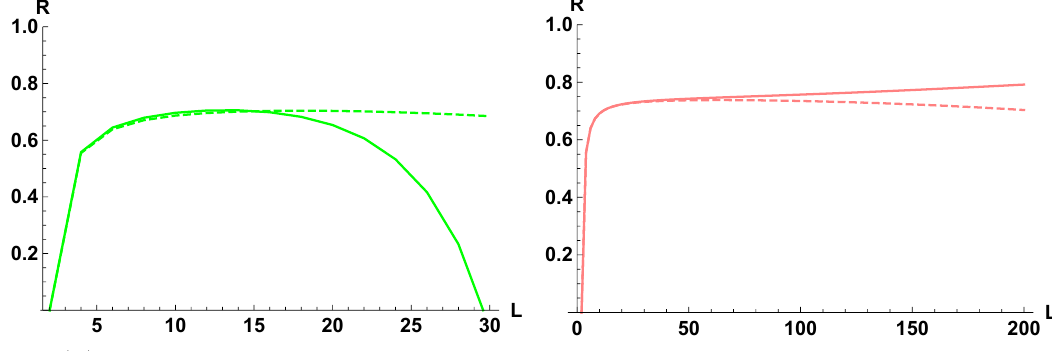
Figure 1. The ratio of vanishing multipoles R ( M ) ( L, δ = 1 / 2) plotted as a function of L for the 2 six geometries we are considering. Solid lines correspond to the values calculated by the direct BPS method, dashed lines to the values calculated using the indirect method. Note the scale difference of the L axis between the three